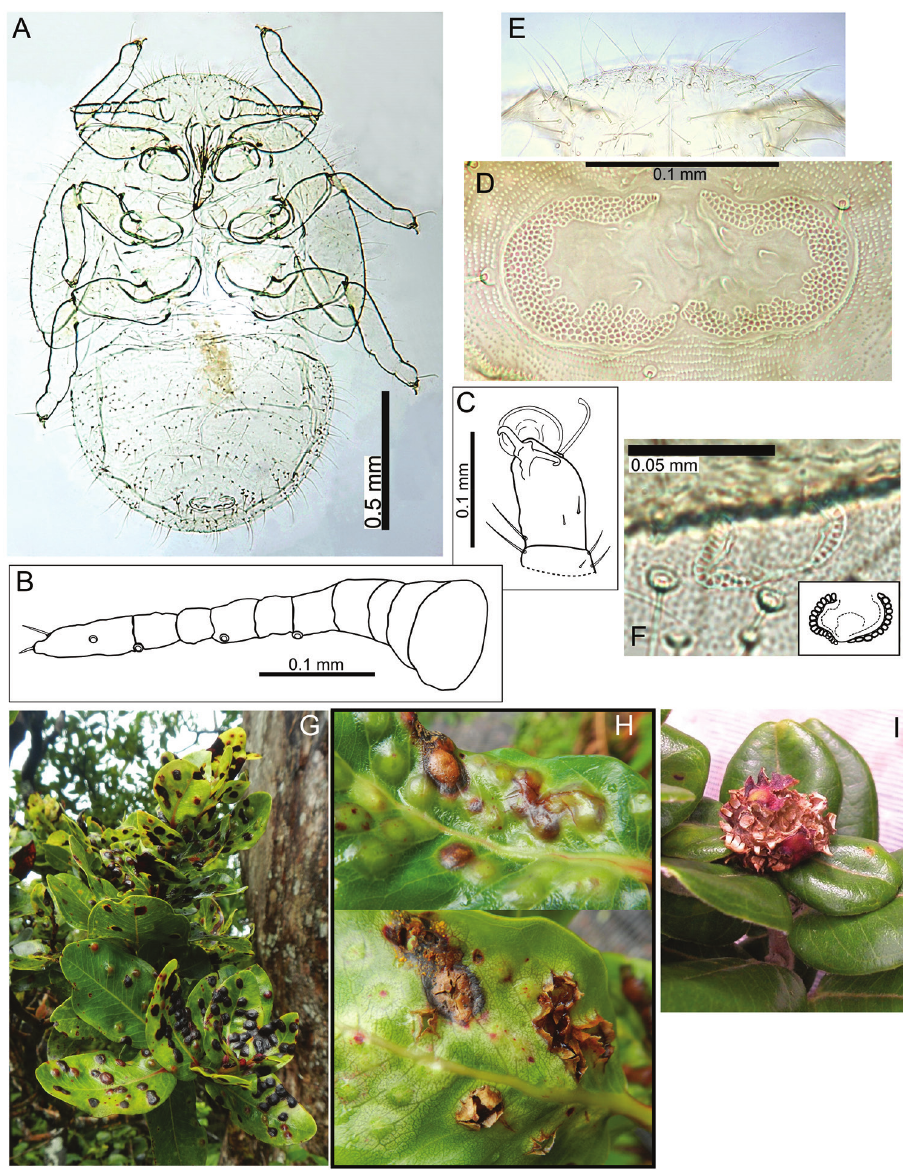
Figure 51. Pariaconus montgomeri and Pariaconus kupua immatures. A–D P. montgomeri : A 5 th instar B antenna C tarsi D anal ring E–F P. kupua : E detail of marginal simple setae F anal ring with detail (inset) G–H P. montgomeri : G distribution of closed flat leaf galls H impression and discolouration on upper leaf surface (above) galls open by valves on lower leaf surface (below) I bud gall from Molokai, may be made by P. molokaiensis